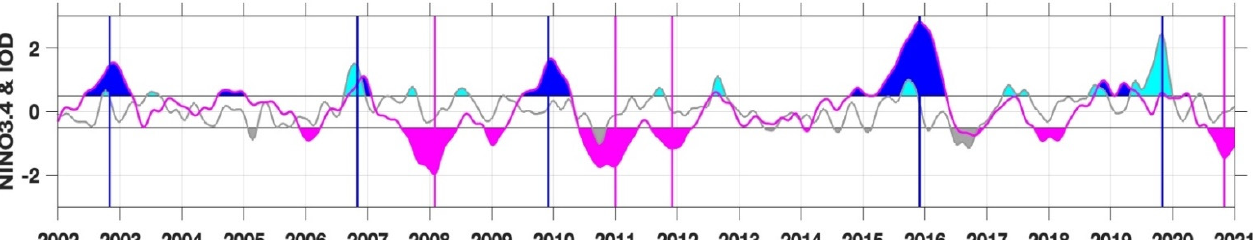
Figure 8. Niño3.4 index (magenta line) and Dipole Mode Index (DMI) (gray line). Values above and below 0.5 are shaded (blue for El Niño and magenta for La Niña). Shaded in cyan denotes Indian Ocean Dipole Mode (IOD) positive, while shaded in gray denotes IOD negative. Blue vertical lines denote El Niño and magenta vertical lines denote La Niña.